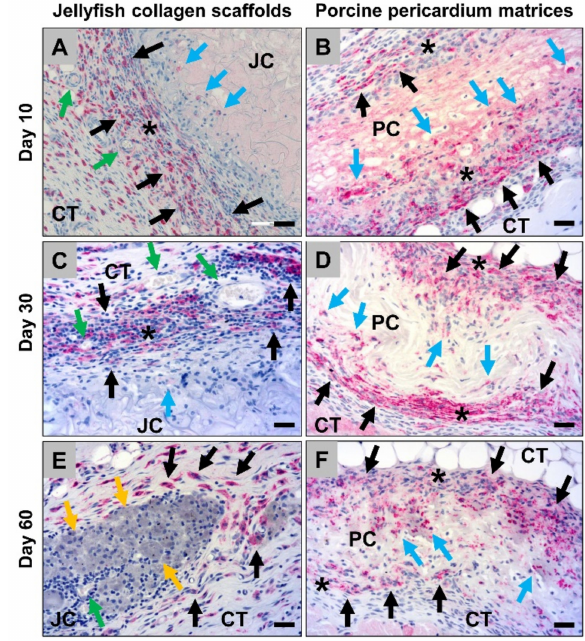
Figure 6. Representative histological images of the anti-inflammatory tissue response to the both analyzed biomaterials, i.e., the jellyfish collagen sca ff olds (JC) and the porcine pericardium matrices (PC) within the subcutaneous connective tissue (CT) based in immunohistochemical detection of the CD163-expression at day 10 post implantationem ( A , B ), day 30 ( C , D ) up to day 60 post implantationem ( E , F ). Black asterisks = cell walls at the material surfaces, black arrows = CD163-positive macrophages within the surrounding connective tissue, blue arrows = CD163-positive macrophages within the biomaterials, green arrows = blood vessels, yellow arrows = CD163-negative macrophages with an increased cytosolic volume (CD163-immunostainings, 20 × magnifications, scalebars = 20 µ